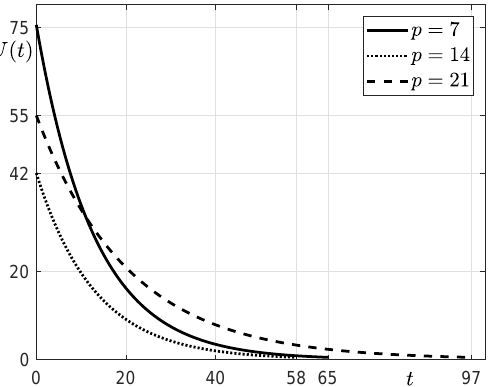
Figure 3. Estimation of the unidentified confirmed patients U from 17 July 2020 to the end of the epidemic with different p